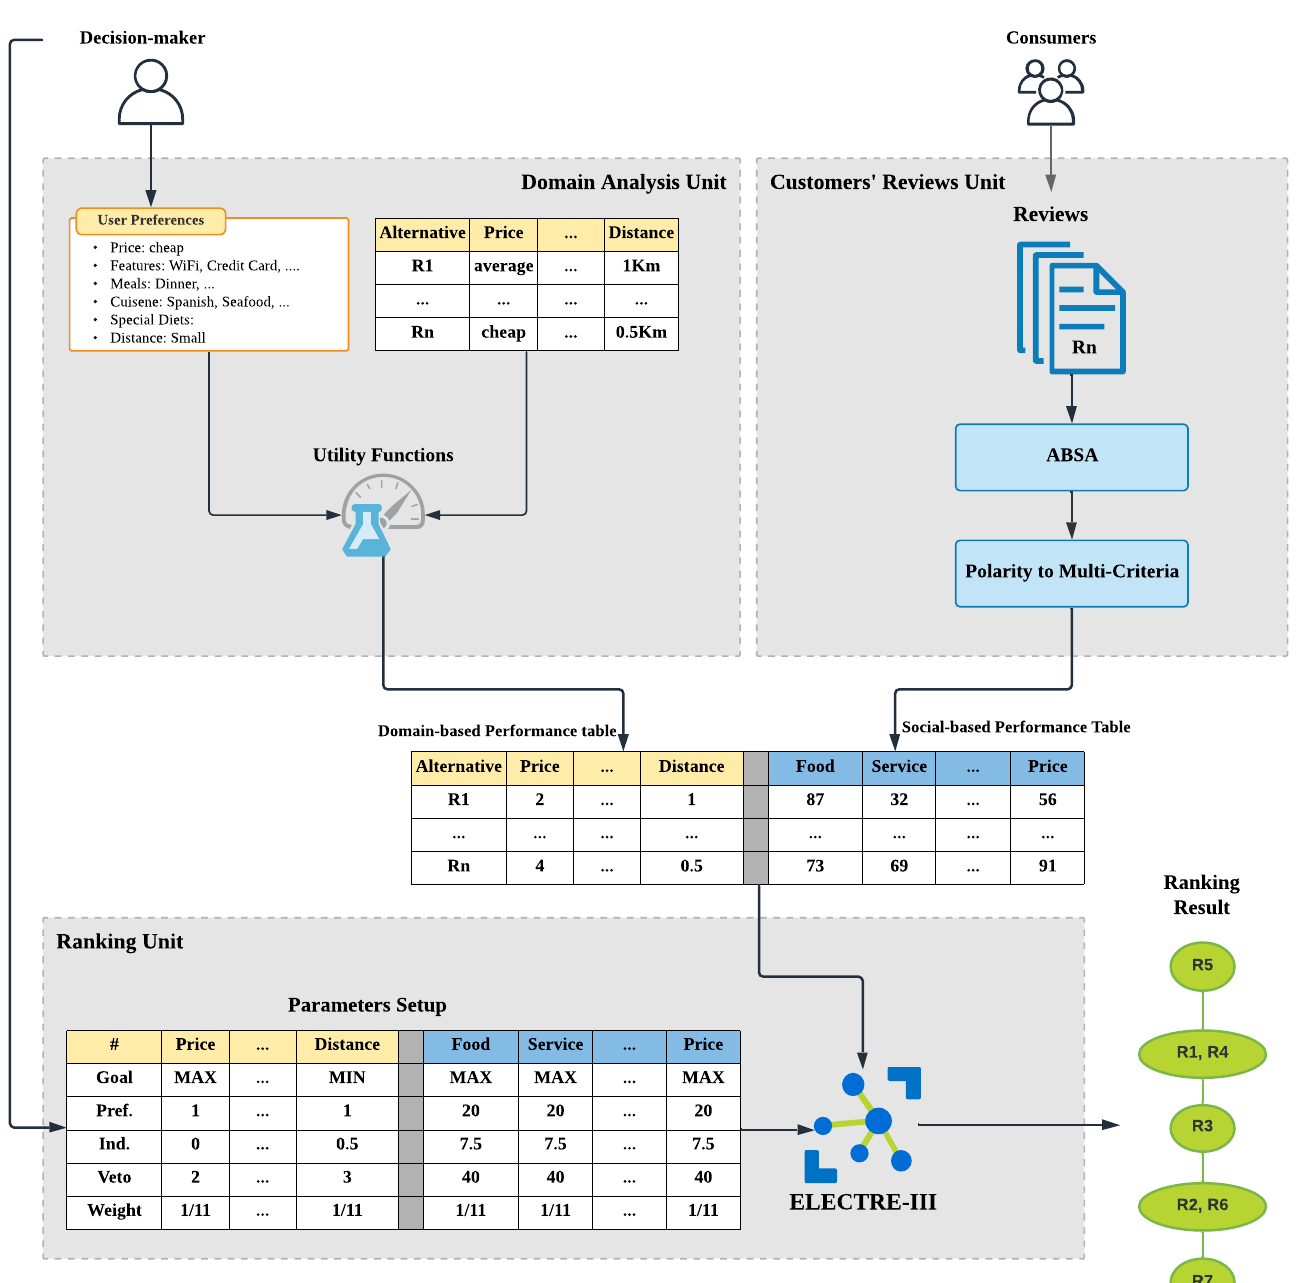
Figure 2. The architecture of